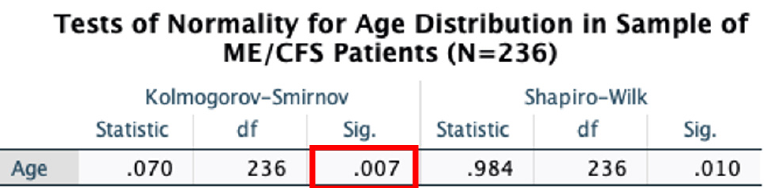
Figure 9. Kolmogorov-Smirnov normality test showed a statistically significant fit of normality ( p = 0.007) for the distribution of age in ME/CFS patients with a history of chronic exposure to mold.